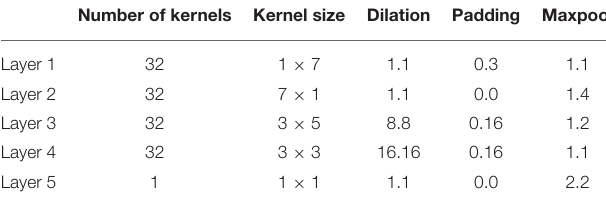
TABLE 4 | CNN parameters of the Audio subnetwork.